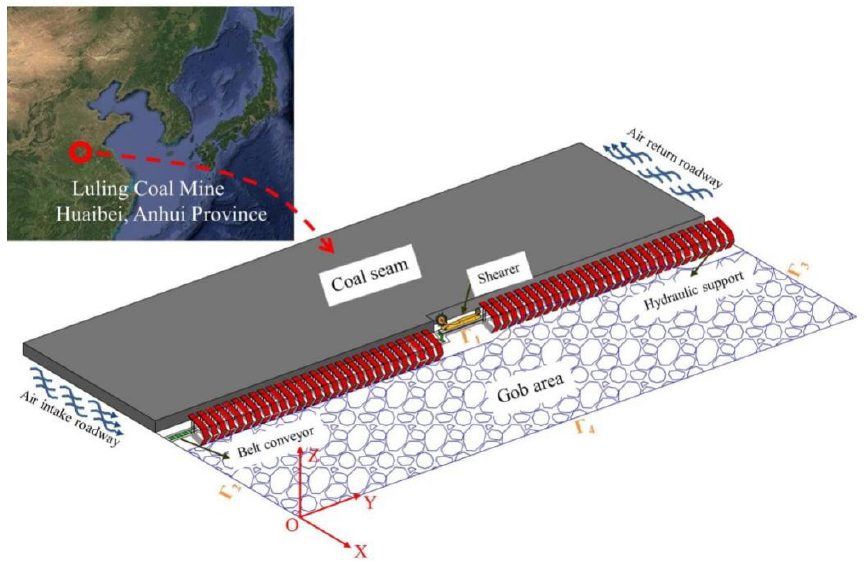
Figure 8. Computational region of the goaf area.